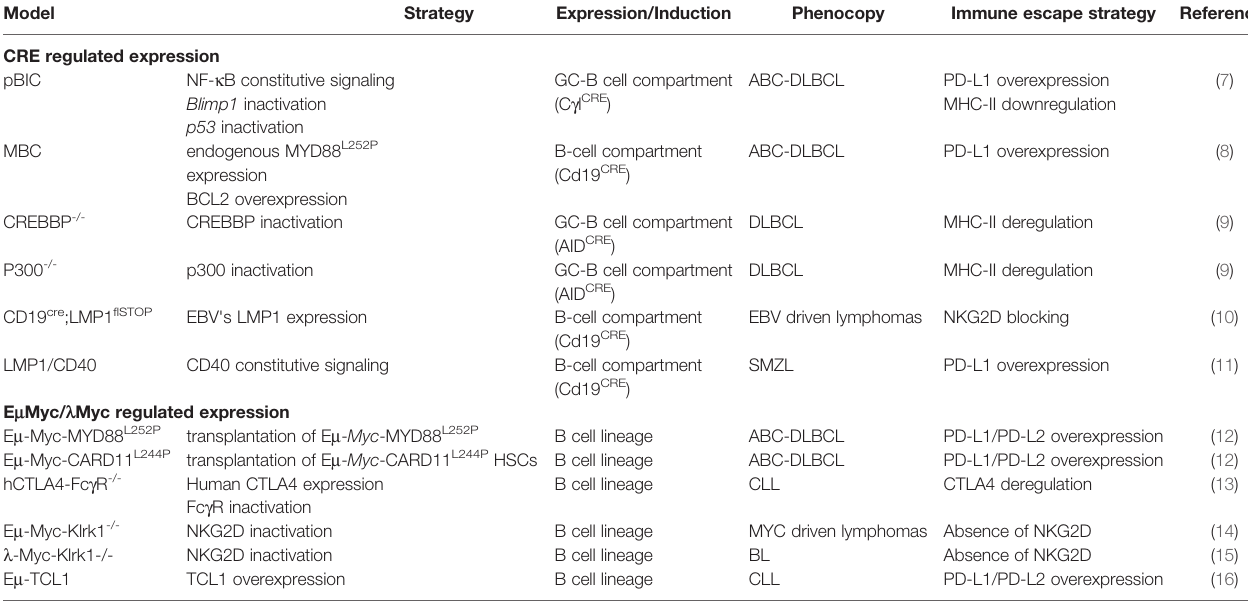
TABLE 1 | Transgenic mouse models. Model